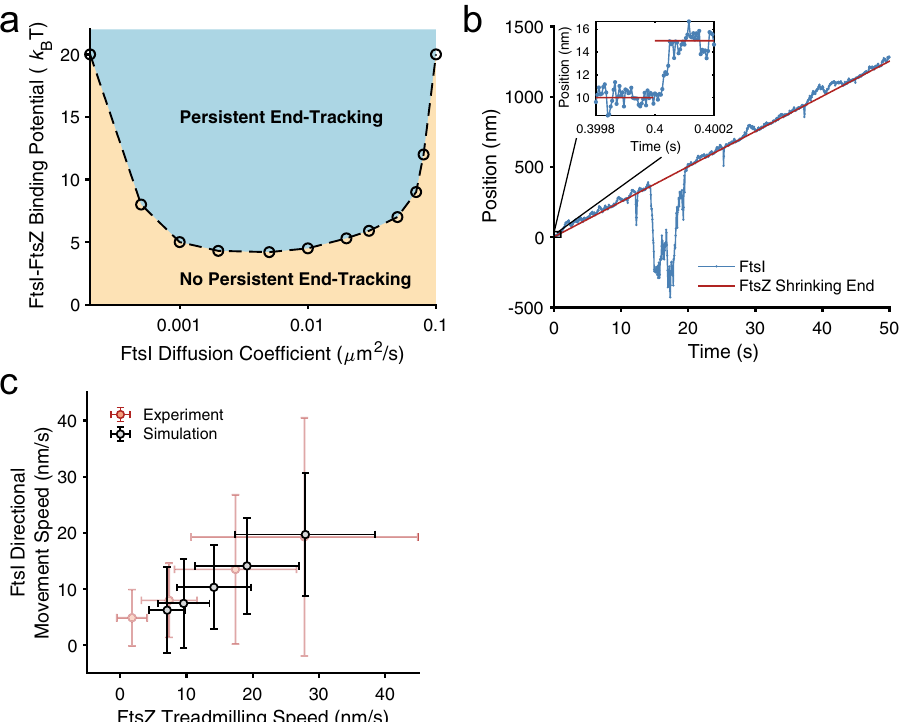
Fig. 2 An FtsZ treadmilling-mediated Brownian ratchet mechanism drives FtsI ’ s directional movement. a Phase diagram depicting the dependence of FtsI ’ s persistent end-tracking (blue-shaded region) on FtsI ’ s diffusion constant and FtsI – FtsZ binding potential. b A representative simulated trajectory of an FtsI molecule persistently end-tracking with a treadmilling FtsZ fi lament. Inset: zoomed-in view of a boxed region of the trajectory. The model parameters for this simulation are: FtsZ ’ s treadmilling speed V Z = 25 nm/s, FtsI diffusion constant D = 0.04 μ m 2 /s, FtsZ – FtsI binding potential U = 10 k = 5 × 10 − 6 s. The full trajectory is plotted every 5 × 10 − 2 s, and the zoomed-in inset is plotted every 5 × 10 − 6 s. B T, and the simulation time step c FtsI ’ s directional speed tightly couples with FtsZ ’ s treadmilling speed. Each of the data points was the average of >80 independent stochastic simulation trajectories using the segments that undergo directional movement. FtsZ ’ s treadmilling speed was fi xed within each trajectory but varied across the ensemble following a Gaussian distribution with a standard deviation (SD) of 30%, in line with the experimental measurements in FtsZ WT and GTPase mutants 13,16